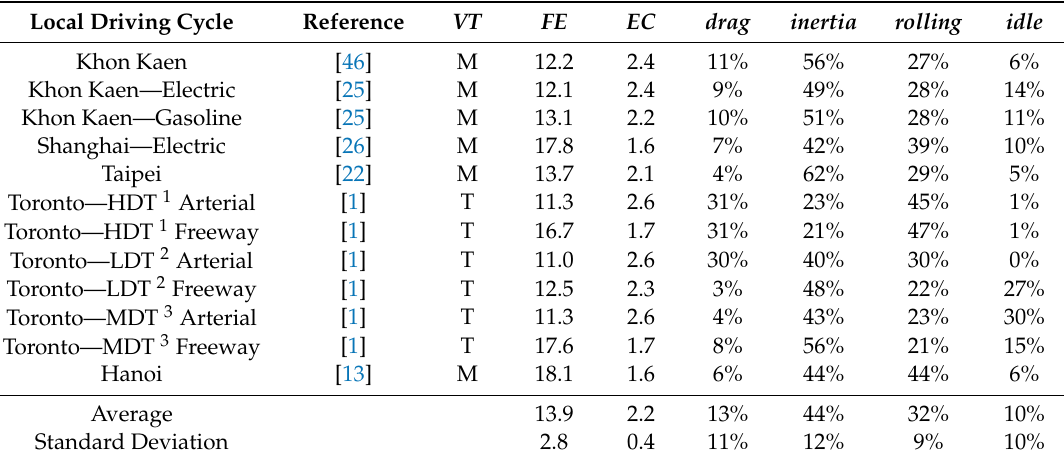
Table 10. EP ENV of the LDCs for trucks (T) and motorcycles